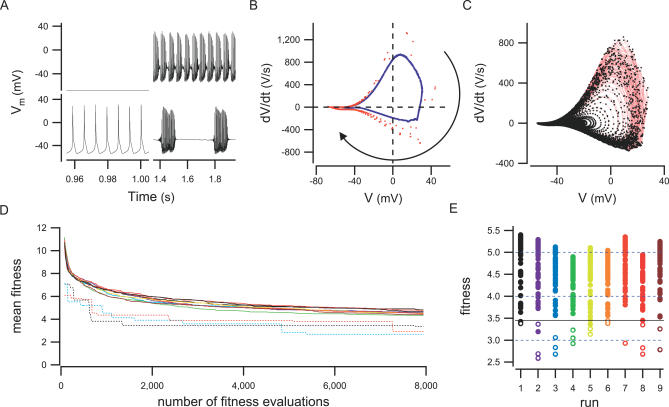
The Search Method(A) Example of the four firing modes of the PC: silent (top left), tonic (bottom left), small bursts (top right), and long bursts (bottom right) obtained with respectively 0, 0.5, 2, and 3 nA of current injected in the soma.(B) The (V,dV/dt) matrix obtained for data when a current of 0.5 nA is injected in the soma. The red points correspond to the first 0.1 s after current injection (transitory period), while the blue ones represent 1.1 s of data recorded 0.9 s after the beginning of current injection (stable period). The black arrow shows the direction followed by successive points in time during a spike.(C) The (V,dV/dt) matrix obtained for data when a current of 3 nA is injected in the soma. The black points represent 2.1 s of data recorded 0.9 s after the beginning of current injection. The red lines link successive points.(D) Time evolution of the mean fitness of the population (full lines). The nine runs, shown as different colors, have very similar evolution, and were stopped after 415 generations. The time evolution of the fitness of the best individual of runs 1, 3, and 7 is shown as dashed lines.(E) Fitness of all individuals of each population when the runs were stopped. Open points represent individuals selected for the rest of the analysis. The full line corresponds to the fitness upper limit for selecting individuals.